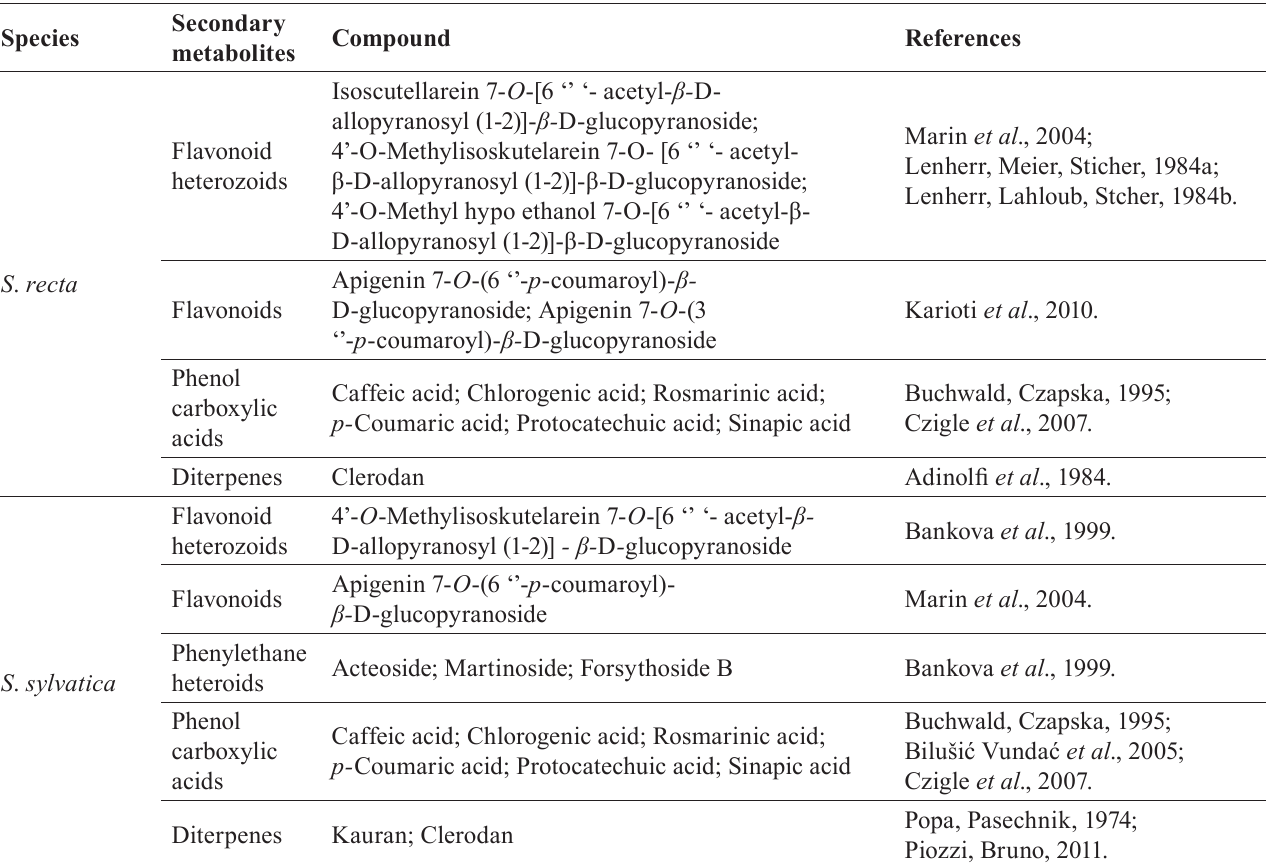
TABLE I - S econdary metabolites of Stachys species